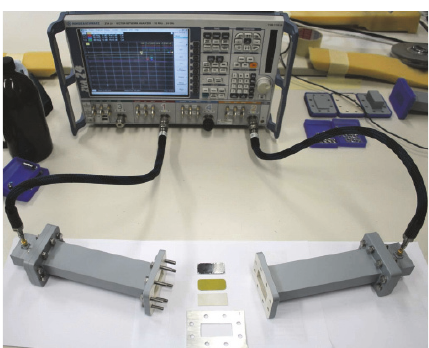
Figure 2: Measurement setup consisting of WR187 waveguides, sample fixture, and R&S ZVA24 network analyzer.